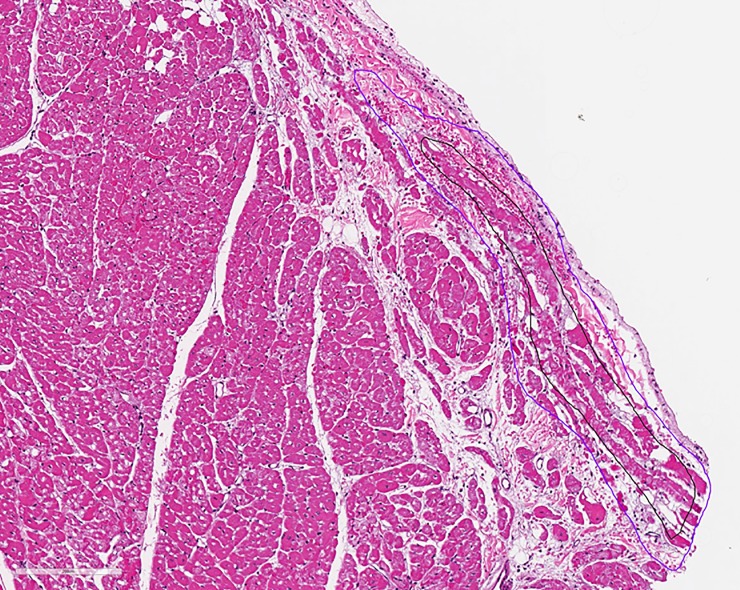
Histopathological slide showing damaged Purkinje fibers outlines in black and the purple outline demarking an area of acute hemorrhage.